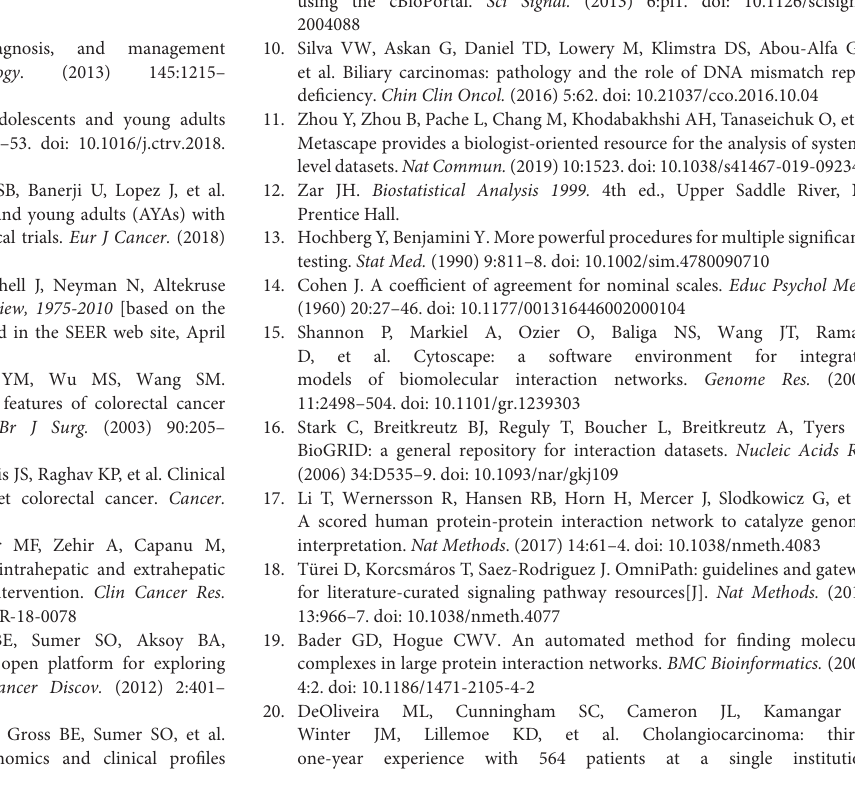
Supplemental Figure 1 | (A) The mutation frequency of FGFR2, PBRM1, ERBB3 elevated in patients of AYA ( < = 45) group; The mutation frequency of BAP1, KRAS, SMAD4 elevated in patients of others ( > 45) groups basing on cohort 3 (MSKCC); (B) A summary of presentative mutation in AYA and other groups basing on cohort 3 (MSKCC). AYA, Adolescents, and young adults; mut, mutation. (C) The difference of RNA expression between the two groups basing on cohort